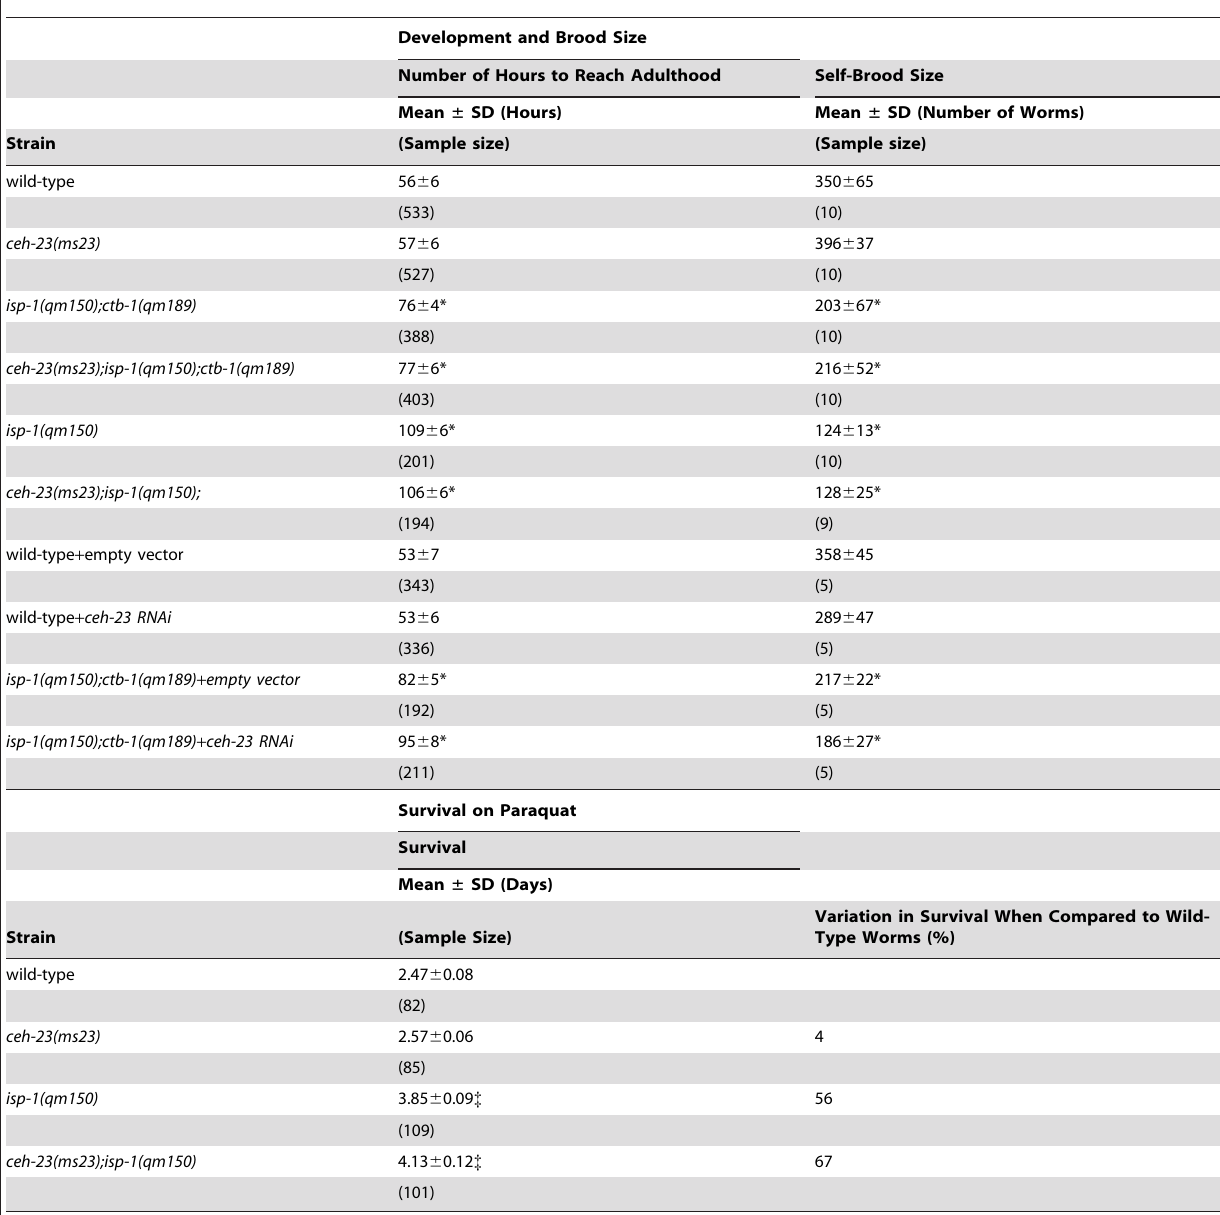
Table 3. Effects of knocking down ceh-23 on the rate of development, self-brood size, and resistance to